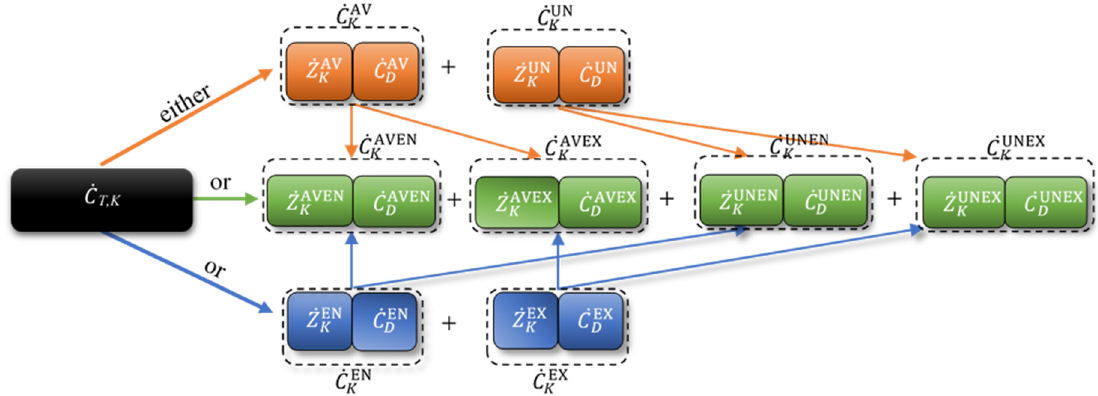
Figure 5. Advanced exergoeconomic analysis splitting.